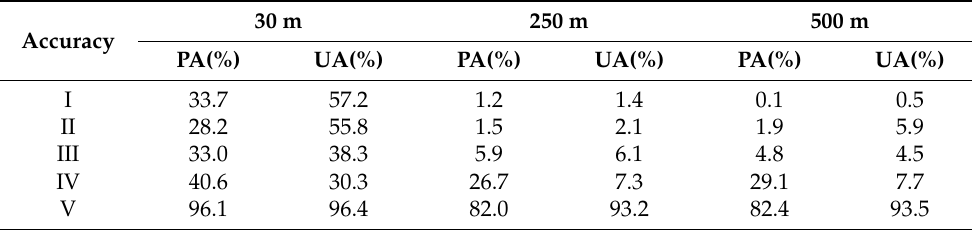
Table 7. Accuracy of woodland FVC (I to V) results. Sentinel-2 images with a resolution of 10 m were used as the reference. See Table 2 for a definition of the coverage